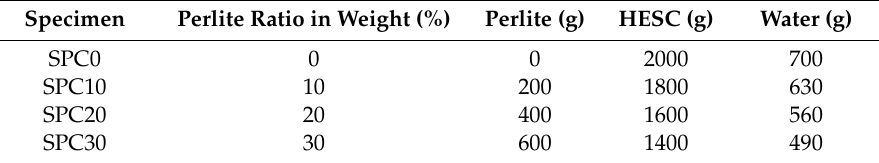
Table 6. Designed di ff erent perlite ratios of the thermal-insulating material specimens.